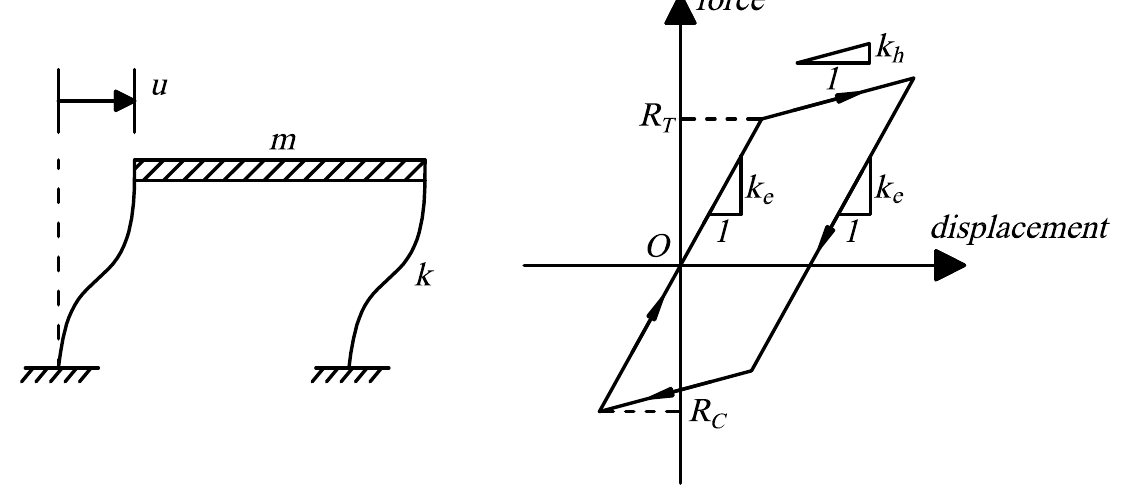
Figure 9. An SDOF with a bilinear inelastic behavior.